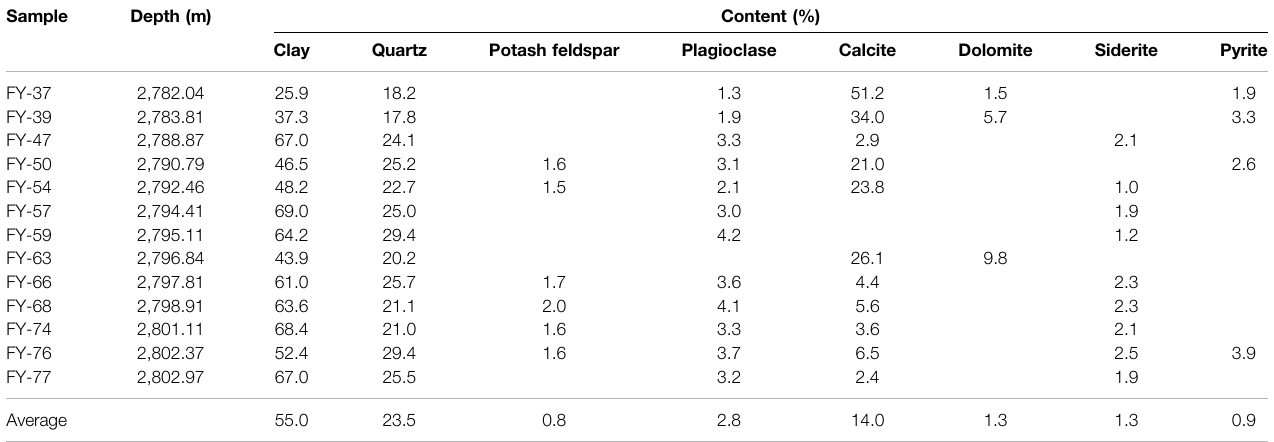
TABLE 1 | Mineral contents of the Dongyuemiao shale in the Fuling area, eastern Sichuan Basin. Sample Depth